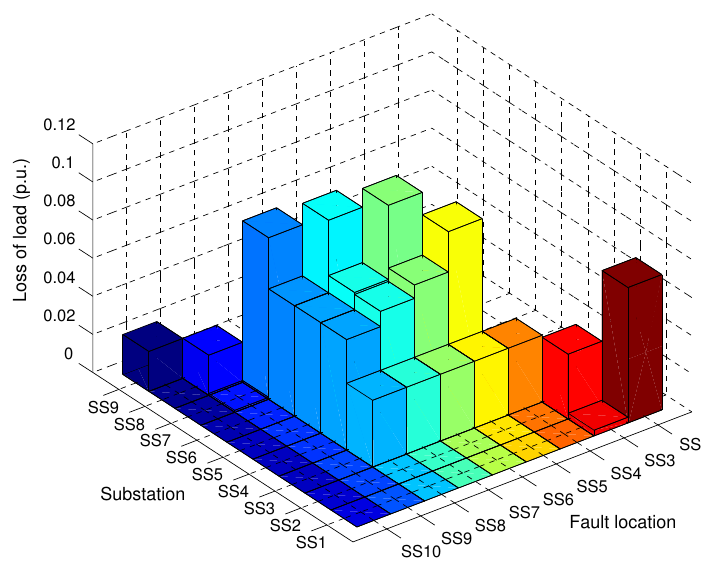
Figure 12. Average loss of